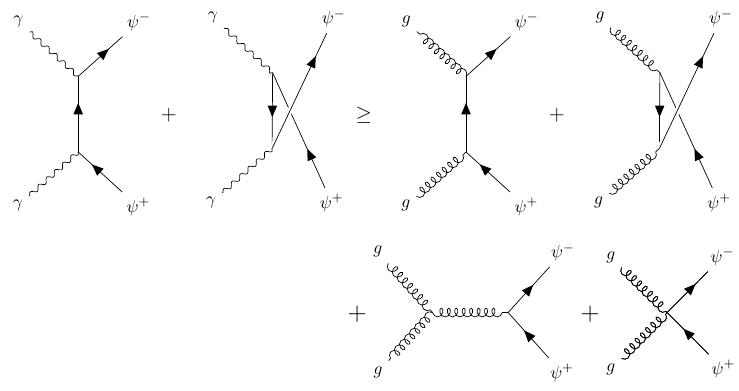
Figure 2 . Tree level diagrams contributing to the pair production in QED and linearized Einstein gravity. We assign the letter B to the diagrams with photons and the letter D to those with